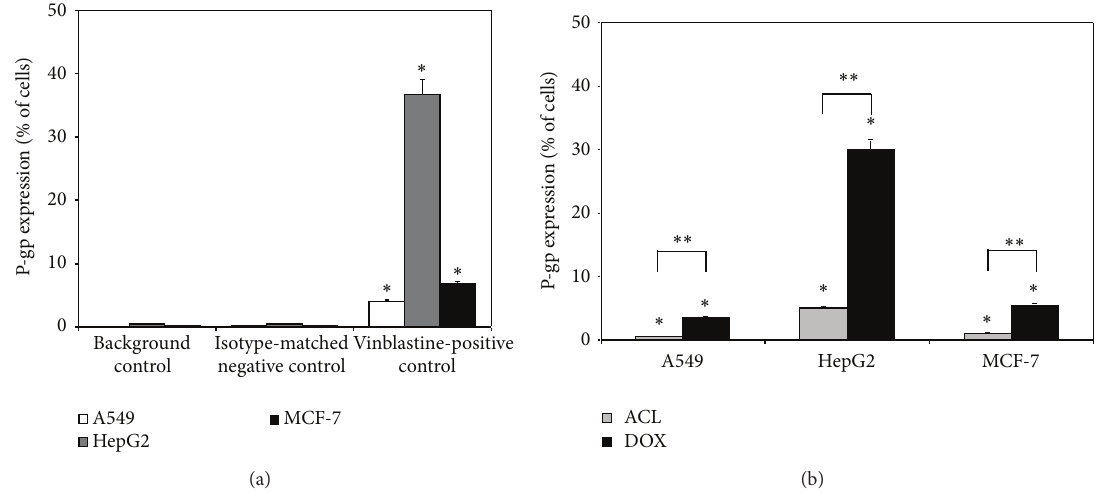
Figure 5: Analysis of the P-gp expression in solid tumor cell lines using vinblastine as positive control (a) and comparison of the effect of ACL and DOX on P-gp expression (b) in drug treated cells. ∗ 𝑃 < 0.05 , significant differences between drugs treated and control cells. ∗∗ 𝑃 < 0.05 , significant differences between cells treated with ACL and